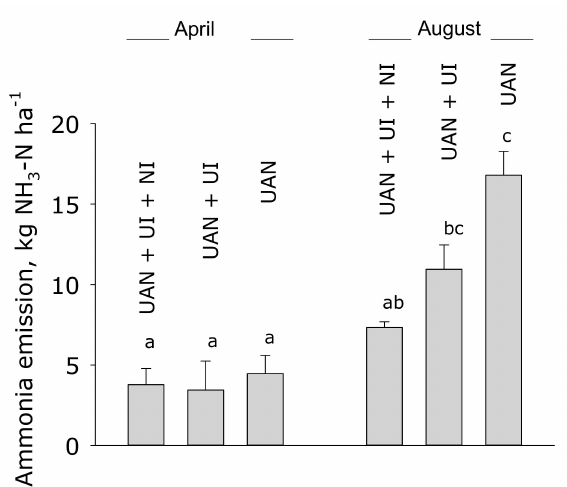
Figure 6. Accumulated emissions of NH 3 from the plots after the application of UAN in April (Error bars: SE, n = 4) and August. The treatments were UAN; UAN without additives, UAN + UI; UAN mixed with urease inhibitor (UI) or UAN + UI + NI; UAN mixed with UI and nitrification inhibitor (NI) (Error bars: SE, n =